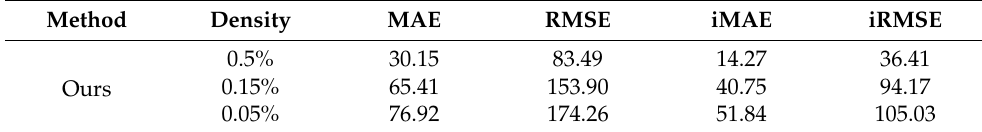
Table 5. Depth completion on VOID with varying sparse depth